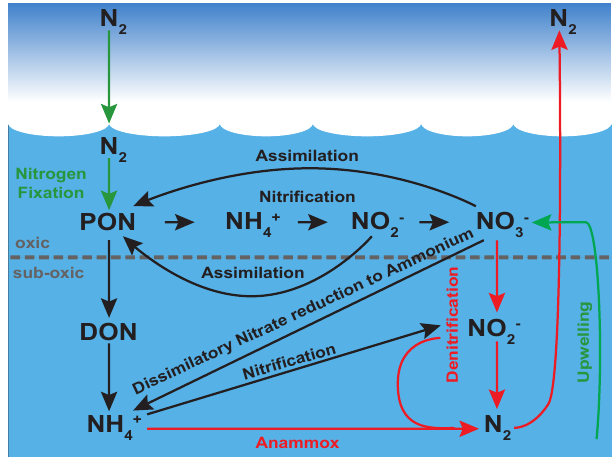
Figure 1. The marine biogeochemical nitrogen cycle. The main re- dox reactions involved are included: in green are the processes re- sponsible for gains of nitrogen to the ocean, and in red are the losses. Modified from Arrigo